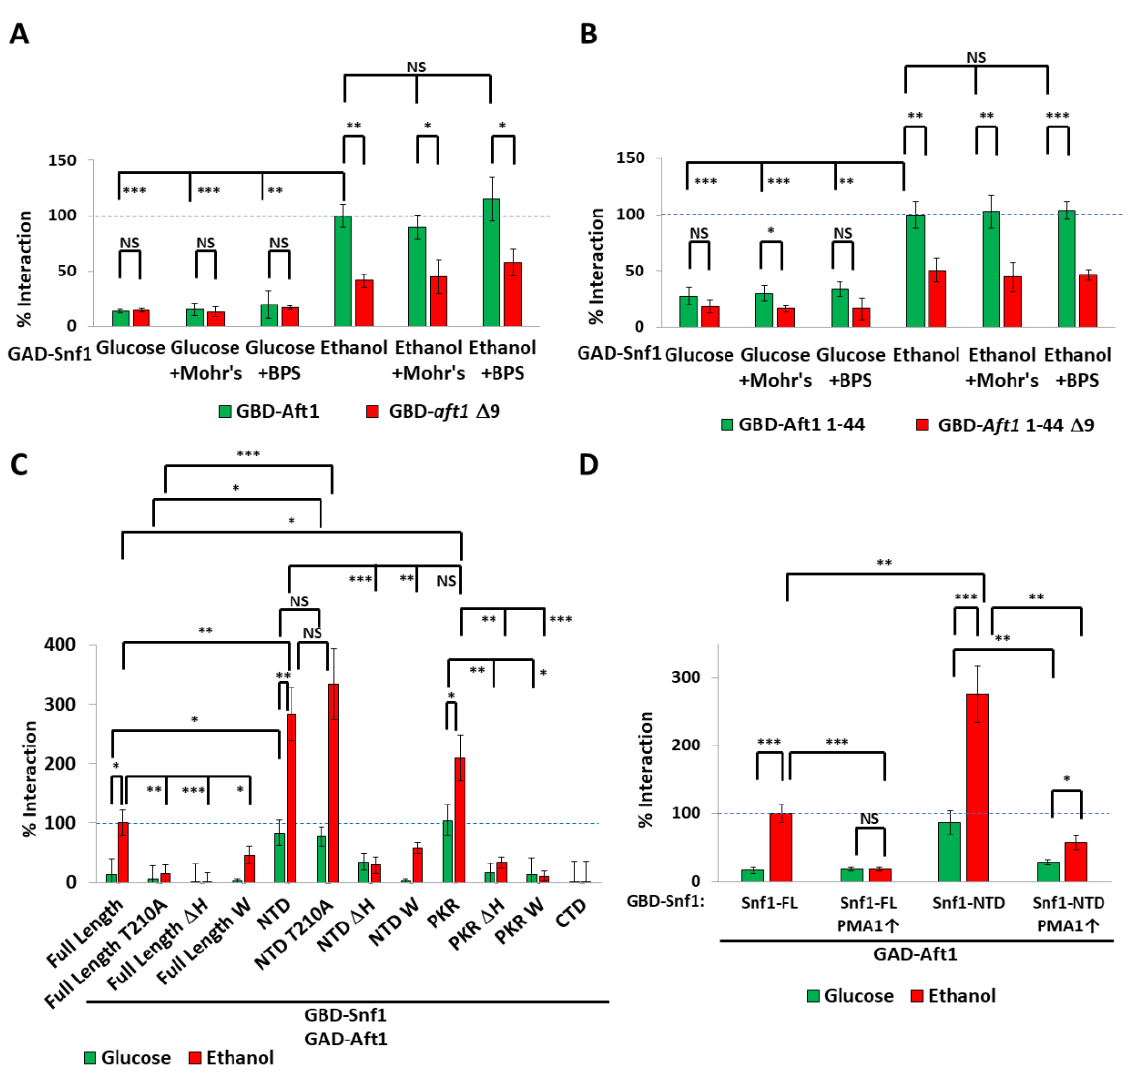
Figure 3. Interactions between Aft1 and Snf1 ( A , B ). Yeast two-hybrid experiment showing interaction between GAD-Snf1 and GBD-Aft1 ( A ) or GBD-Aft1 1-44 ( B ) under the indicated conditions. An amount of 100 µ M BPS or 5 mM Mohr’s salt was added as indicated, and 100% interaction is defined as GAD-Snf1 with GBD-Aft1 ( A ) or GBD-Aft1 1-44 ( B ). N = 3. Error bars are mean ± 1 standard devia- tion. t -tests were performed as indicated. NS = not significant, * = p ≤ 0.05, ** = p ≤ 0.01, *** = p ≤ 0.001. ( C ) Yeast two-hybrid experiment showing interaction between GAD-Aft1 and GBD-Snf1 fragments as described in Figure S1A, and 100% interaction is defined as GAD-Aft1 with GBD-Snf1-FL in eth- anol. N = 3. Error bars are mean ±1 standard deviation. t -tests were performed as indicated. NS = not significant, * = p ≤ 0.05, ** = p ≤ 0.01, *** = p ≤ 0.001. ( D ) Yeast two-hybrid experiment showing interaction between GAD-Aft1 and GBD-Snf1. FL = full length Snf1 (aa 1-633). NTD = aa1-391. Pma1 was hyperactivated (Pma1 ↑ ) by simultaneously truncating the final 18 amino acids of Pma1 (Pma1- Δ901) and deleting HSP30 [42]. 100% interaction is defined as GAD-Aft1 with GBD-Snf1-FL in eth- anol. N = 3. Error bars are mean ±1 standard deviation. t -tests were performed as indicated. NS = not significant, * = p ≤ 0.05, ** = p ≤ 0.01, *** = p ≤ 0.001.